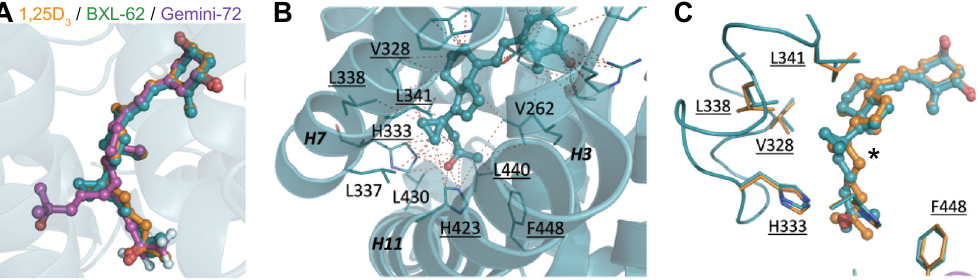
Figure 3. Crystal structure of zVDR—BXL-62. ( A ) Superposition of 1,25D 3 , BXL-62 and Gemini-72 ligands in the crystal structures of the zVDR LBD complexes (zVDR-1,25D 3 : PDB 2HC4; zVDR-BXL-62: PDB 7BNS; zVDR-Gemini-72: PDB 3O1D); ( B ) Close-up view of the VDR ligand-binding pocket around the BXL-62 side chain (in blue). Residues that contact the ligand with a cutoff of 4.0 Å are labelled. Residues that form additional or stronger contacts with BXL-62 compared to 1,25D 3 are underlined; ( C ) Superposition of BXL-62 (blue) and 1,25D 3 (orange) side chains within the VDR ligand-binding pocket with residues that form stronger contacts with BXL-62 than with 1,25D 3 are highlighted. * indicates the torsion angles of C16 ‐ C17 ‐ C20 ‐ C22.